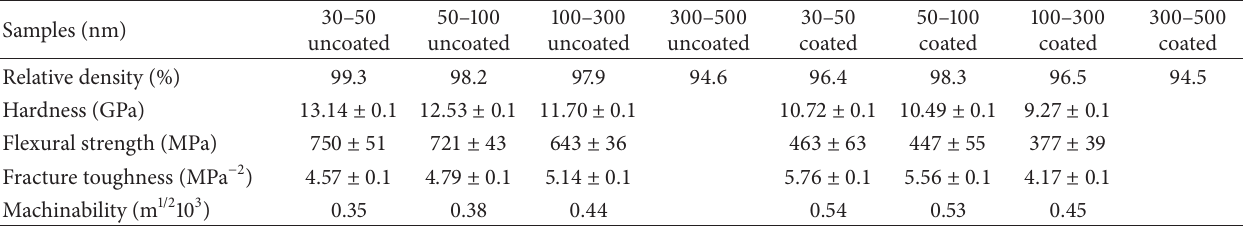
Table 1: Relative density, hardness, and mechanical properties of the